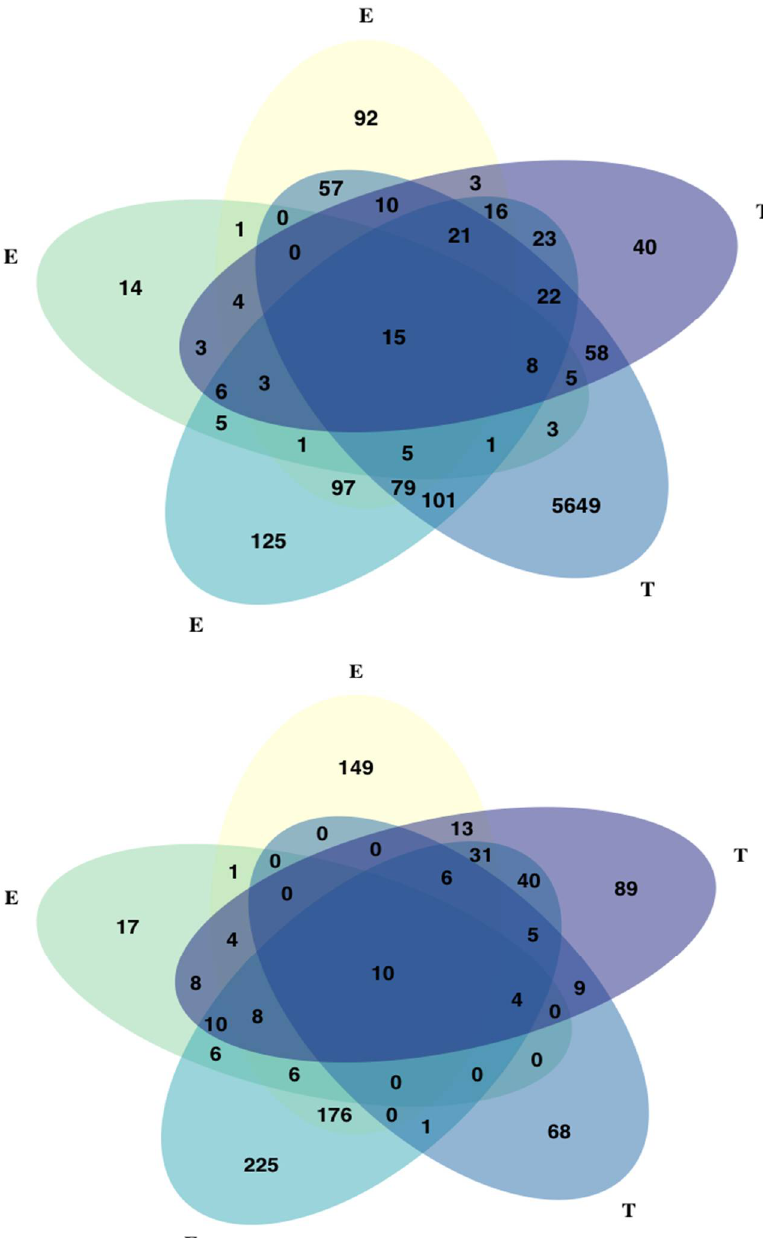
Figure A6. Combined results of all GEA and GWAS analyses. GWAS analyses (“T”) are Mixed Linear Model (MLM) in purple, and Bayesian Sparse Linear Mixed Model (BSLMM) in blue. GEA analyses (“E”) are Bayenv in yellow; RDA in dark green and MLM in light green. In the graph on top, BSLMM PIP threshold for significant SNPs was 0.01, in the graph at the bottom, PIP threshold was 0.05. The number and identity of shared SNPs among all methods (dark blue) is almost consistent between the two graphs.